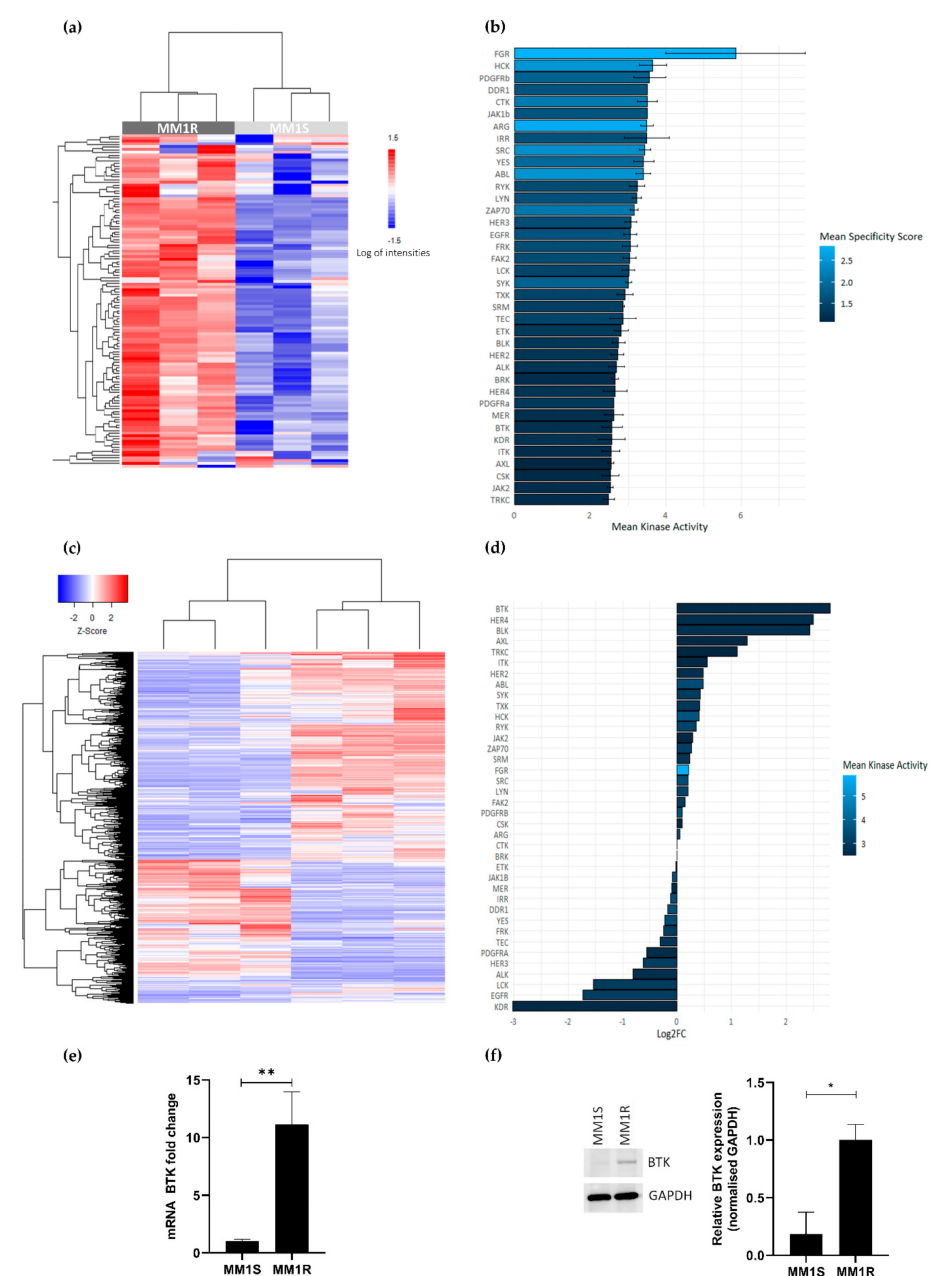
Figure 1. ( a ) Heatmap showing phosphorylation intensities of peptides serving as substrates for tyrosine kinases. Figure shows hyperphosphorylated (red) or hypo-phosphorylated (blue) peptides in MM1R ( n = 3) and MM1S ( n = 3) samples. ( b ) Ranking of hyperactivated kinases in MM1R versus MM1S cells based on the top 20 significant differentially phosphorylated peptides. Fill color of the bars is based on the kinase specificity score, indicating the specificity of differences in kinase activity with respect to the quantity of peptides used for predicting the corresponding kinase ( c ) Heatmap representation of differentially expressed genes (logFC >|1|, p < 0.01) in MM1R versus MM1S cells as determined by RNA sequencing. n = 3 biologically independent replicates per cell line. ( d ) Ranking of the top overexpressed kinases in MM1R versus MM1S cells based on their log2-fold change as determined by RNA sequencing. Fill colors of the bars are a measure for kinase activity as measured via the PTK-specific phosphopeptide array. ( e ) Relative Bruton’s tyrosine kinase (BTK) mRNA levels in MM1R and MM1S cells. Data are plotted as the mean ± s.d., n = 3 biologically independent replicates (** p = 0.0035, unpaired t -test). ( f ) Western immunoblot detection and quantification of basal BTK and GAPDH protein levels in MM1R and MM1S cells. Data are plotted as the mean ± s.d., n = 3 biologically independent replicates (* p = 0.0385, unpaired t